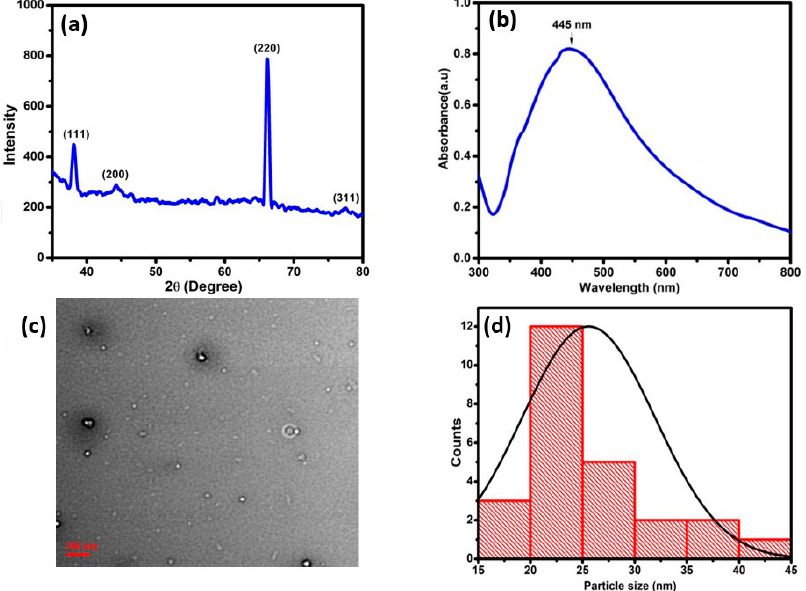
Figure 1. ( a ) XRD diffractogram and ( b ) UV-Vis spectroscopy; ( c ) TEM image of silver nanoparticles; ( d ) average particle size.